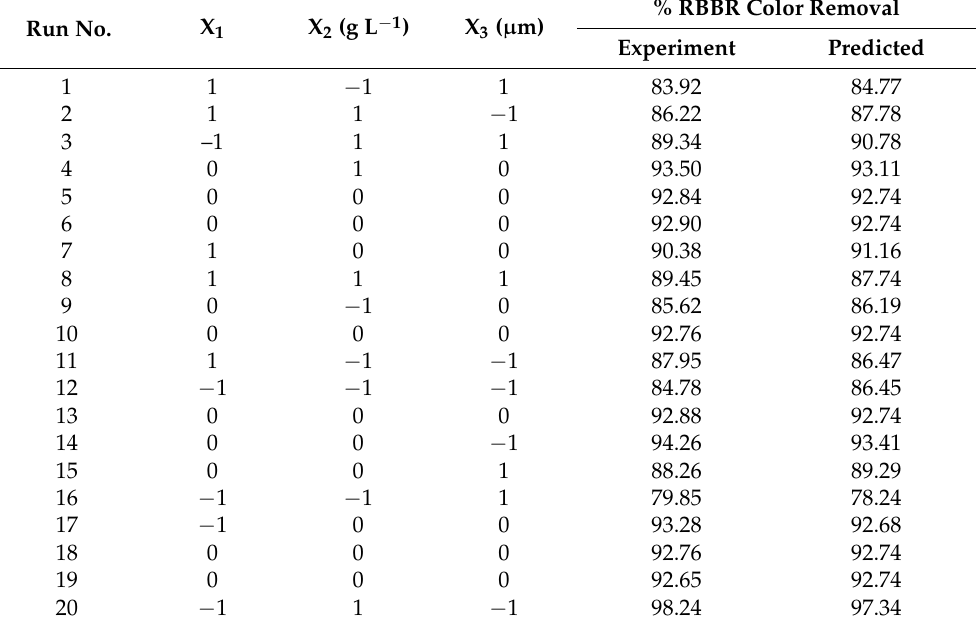
Table 3. Three-factor full factorial central composite design (CCD) matrix for RBBR dye removal by WSBAC adsorbent. (Dye concentration: 175 mg L − 1 ; agitation speed: 150 rpm; contact time: 12 h). Run